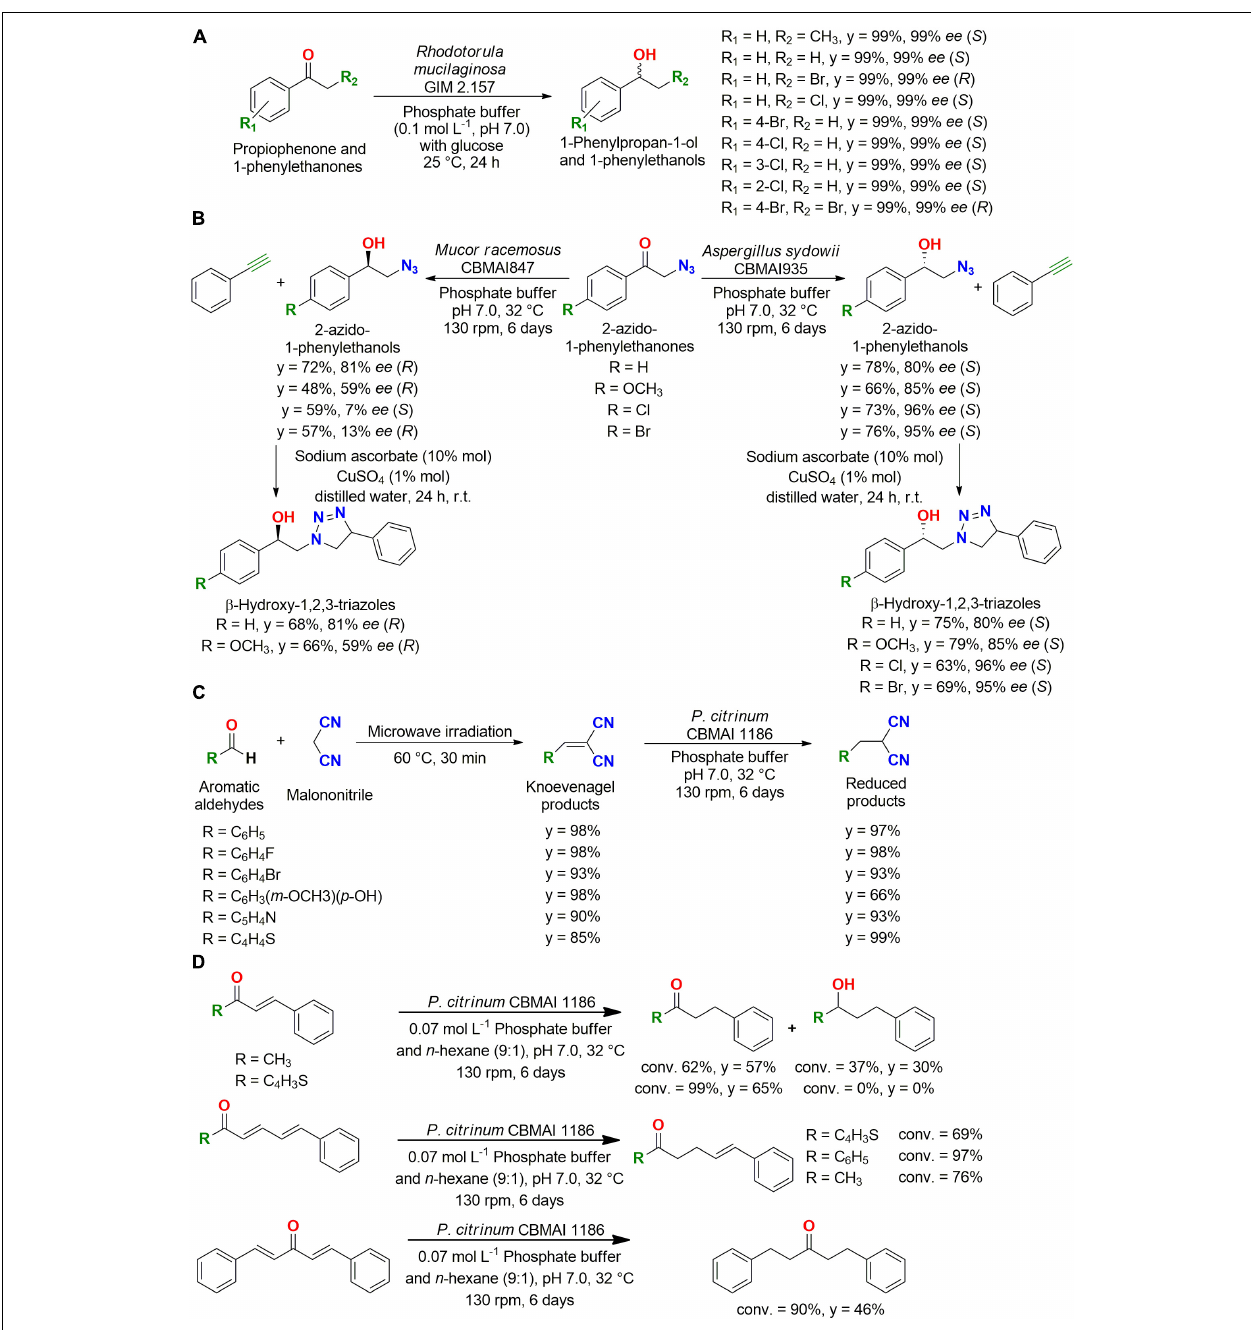
for reduction of propiophenone; R. mucilaginosa GIM 2.157 resulted in over 95% yield with 99% ee for three cycles, and Rhodotorula rubra AS 2.2241 gave the same results (95% yield with 99% ee ) for nine cycles (Liu et al.,